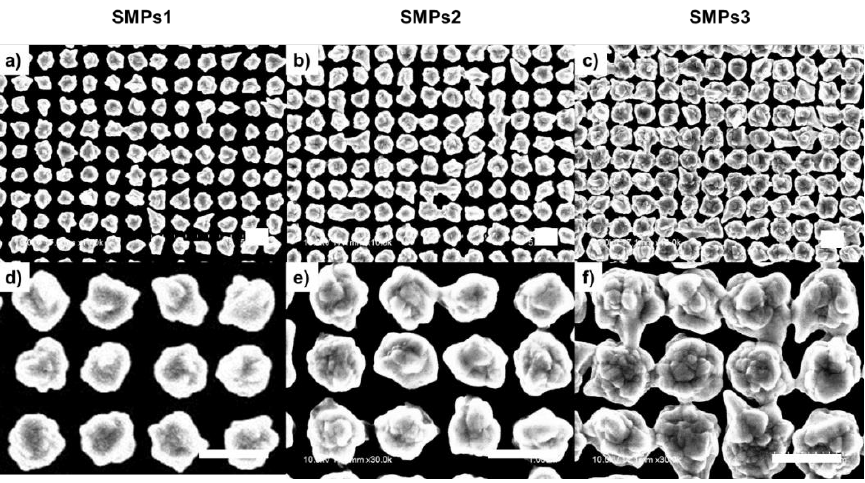
Figure 2. Representative Raman spectra of SMPs3 before and after resist removal.